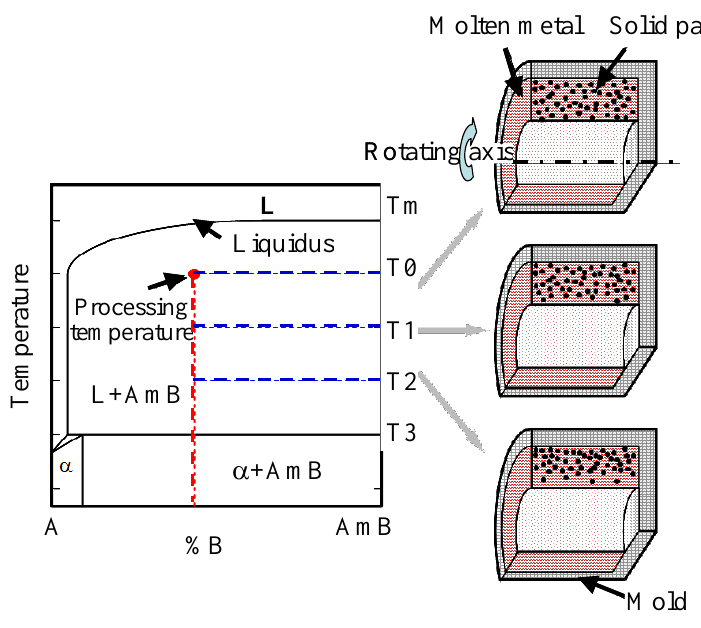
Figure 1. The schematic illustration of CSPM [15].